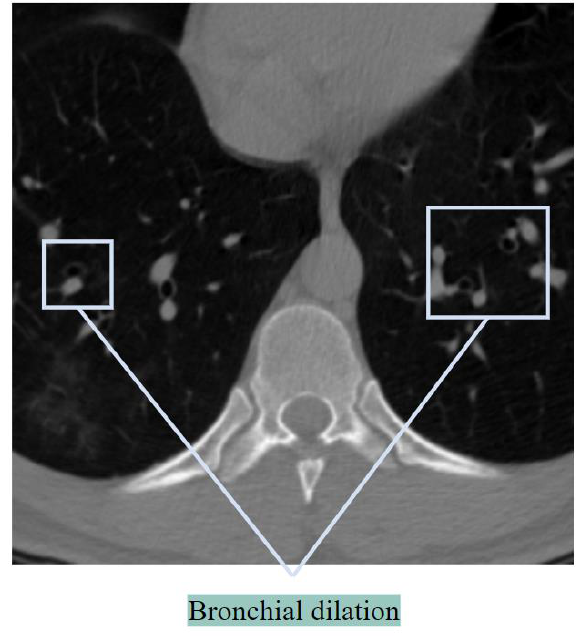
Figure 3. Bronchial dilation showed in a CT scan. Distortion of the Bronchial Tree